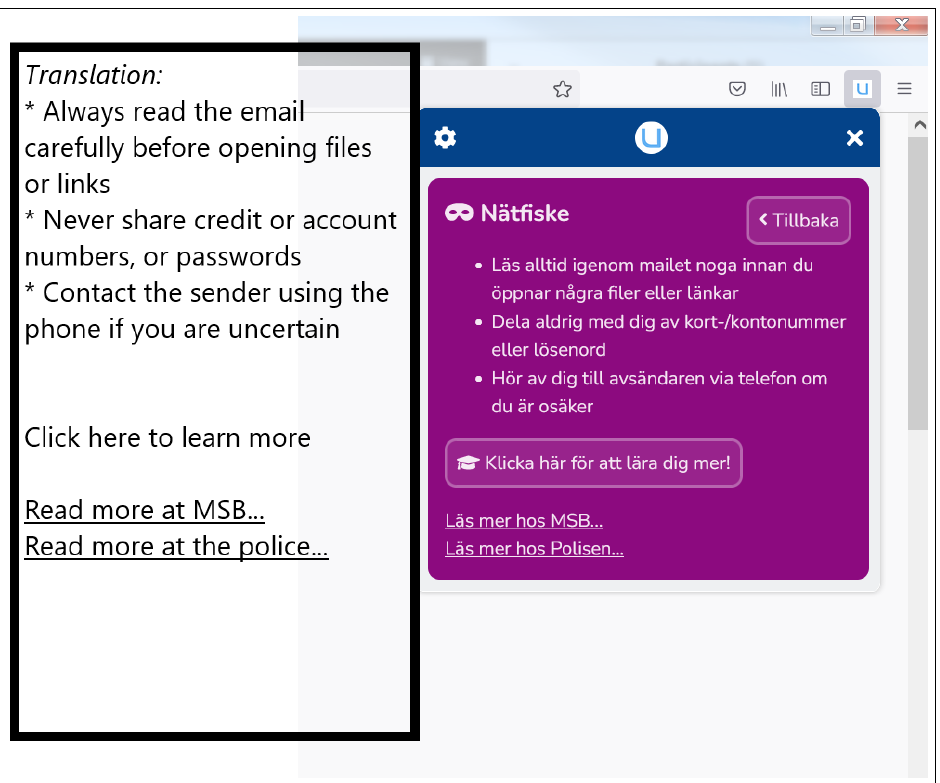
Figure 3. Demonstration of CBMT-based